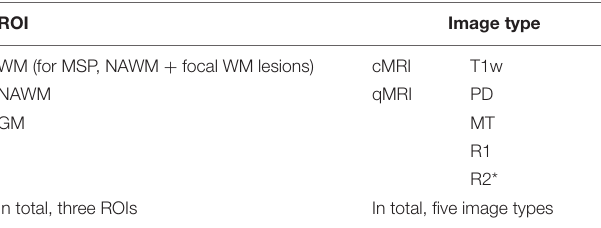
TABLE 2 | Overview of the independent feature sets per participant. ROI Image